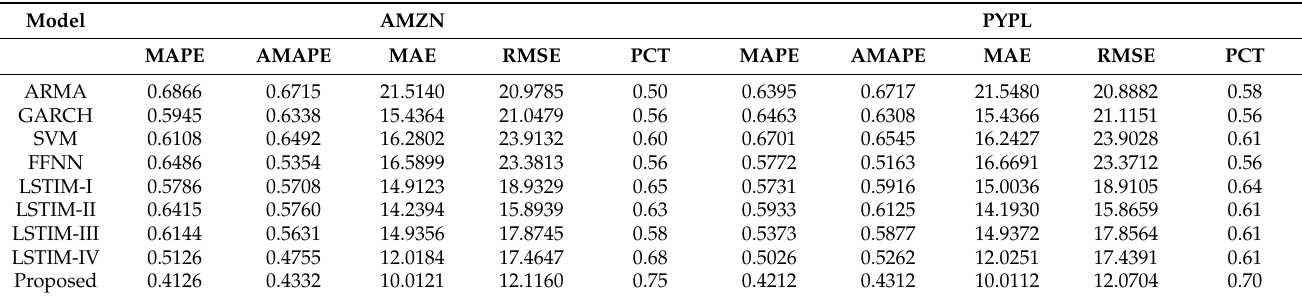
Table 13. Prediction performance for 150 days: AMZN and